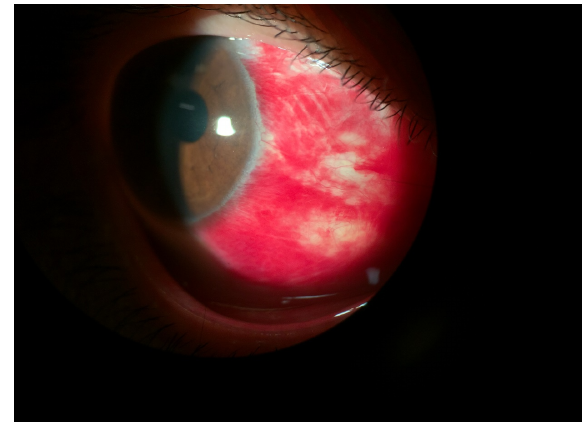
Figure 1: Slit-lamp image of the patient’s right eye at the onset of menstruation shows nasally located subconjunctival hemorrhage.